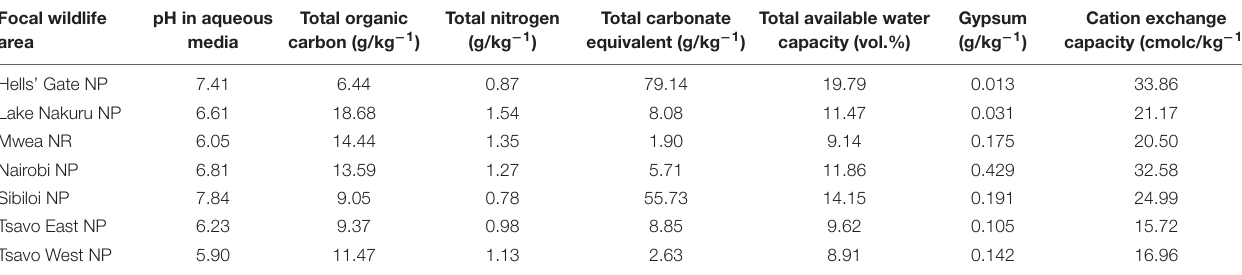
TABLE 3 | Average values of selected edaphic covariates of the focal wildlife areas (NP, National Park; NR, National Reserve) in Kenya. Focal wildlife area